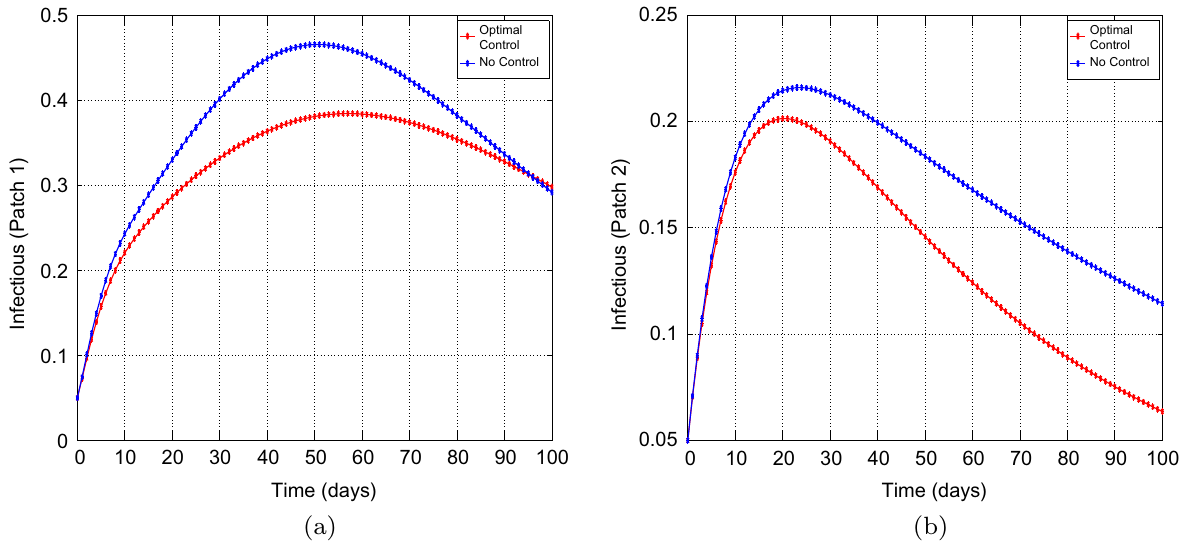
Figure 4. Simulation outcomes of the presented two patch COVID-19 mathematical model for case 1 under asymmetric weak coupling ( a ) the number of infected humans in patch 1 ( b ) the number of infected humans in patch 2. In both figures, the red curves and blue curves represent the infected population, with optimal control and no optimal control respectively.